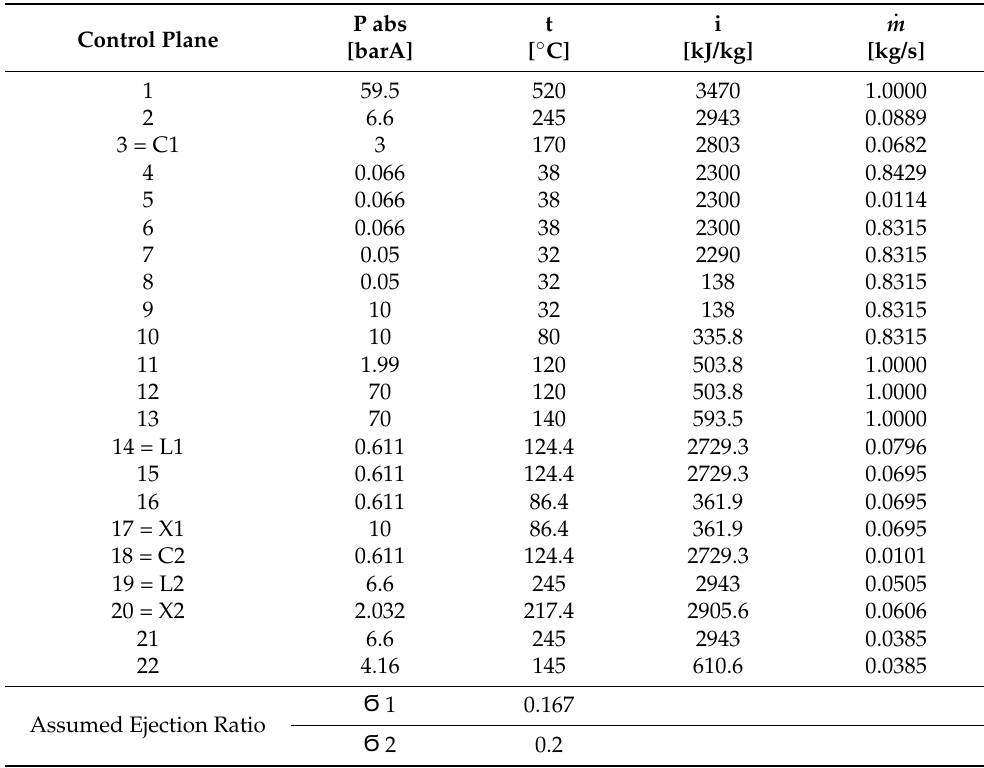
Table 5. Thermodynamic parameters of the working fluid in the control planes of the regenerative cycle with two-stage